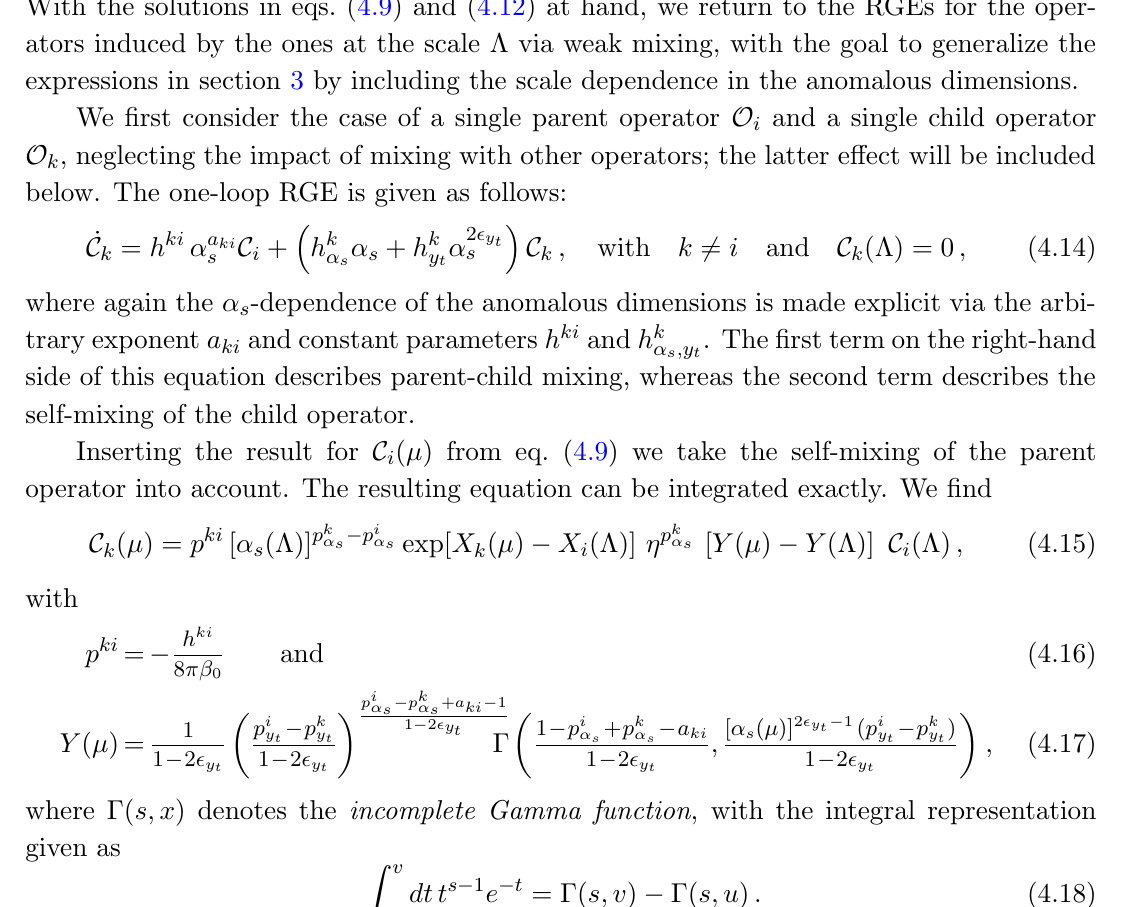
Figure 2 . Running of C tB in di(cid:11)erent scenarios: neglecting the term (cid:24) y 2 dashed), assuming a scale-independent ADM (blue dashed), exact (black) and with our approxi- mation (red, overlapping with the black